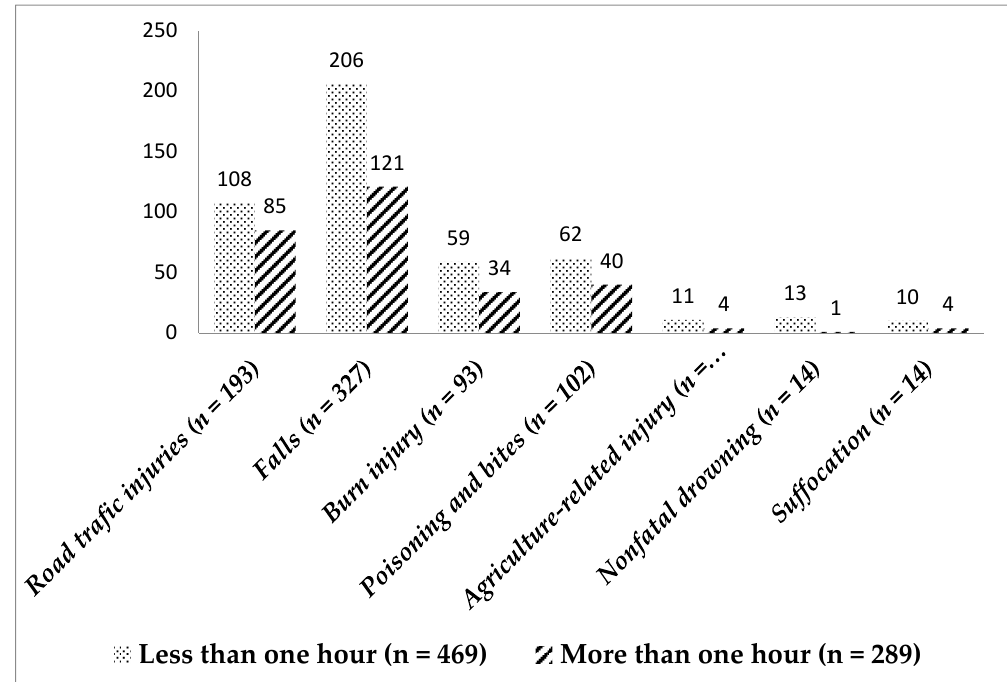
Figure 2. Health care-seeking with the golden hour in different